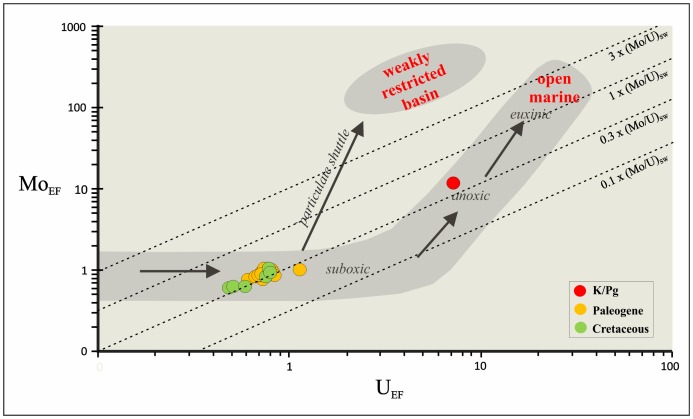
MoEF vs UEF covariation.MoEF vs UEF covariation for the Cretaceous–Paleogene (K/Pg) boundary section at Caravaca (Southeast Spain).